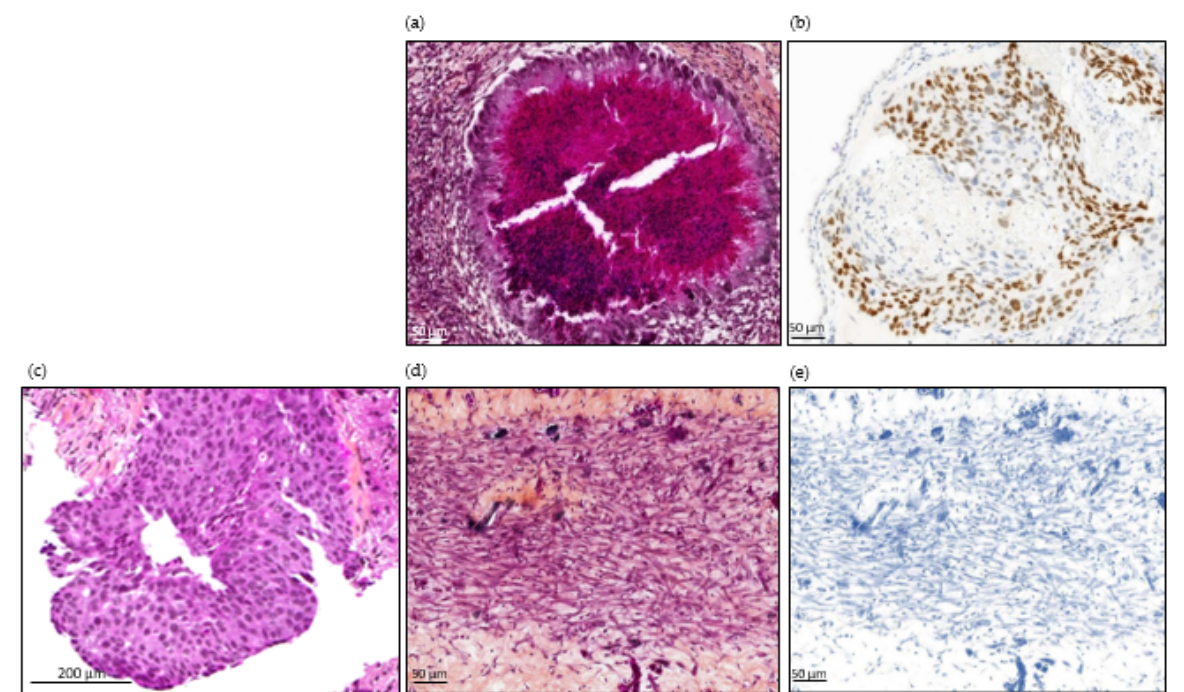
Figure 5. Histopathological images of tumor from patient number 24, at diagnosis and in ovo tumors from cell line and CTCs. ( a ) H&E staining of an HCC827 ‐ derived in ovo tumor. ( b ) TTF ‐ 1 immunostaining of an HCC827 ‐ derived in ovo tumor. Scale bar = 50 μ m (10× magnification). ( c ) H&E staining of lung biopsy from patient 24: invasive tumor composed of sheets of tumor cells that lack acini, tubules, and papillae with mucin production. Focally, cribriform patterns can be seen. Scale bar = 200 μ m (10× magnification). ( d ) H&E staining of in ovo tumor derived from patient 24’s CTCs. ( e ) TTF ‐ 1 immunostaining of in ovo tumor derived from patient number 24’s CTCs. Scale bar = 50 μ m (10× magnification).